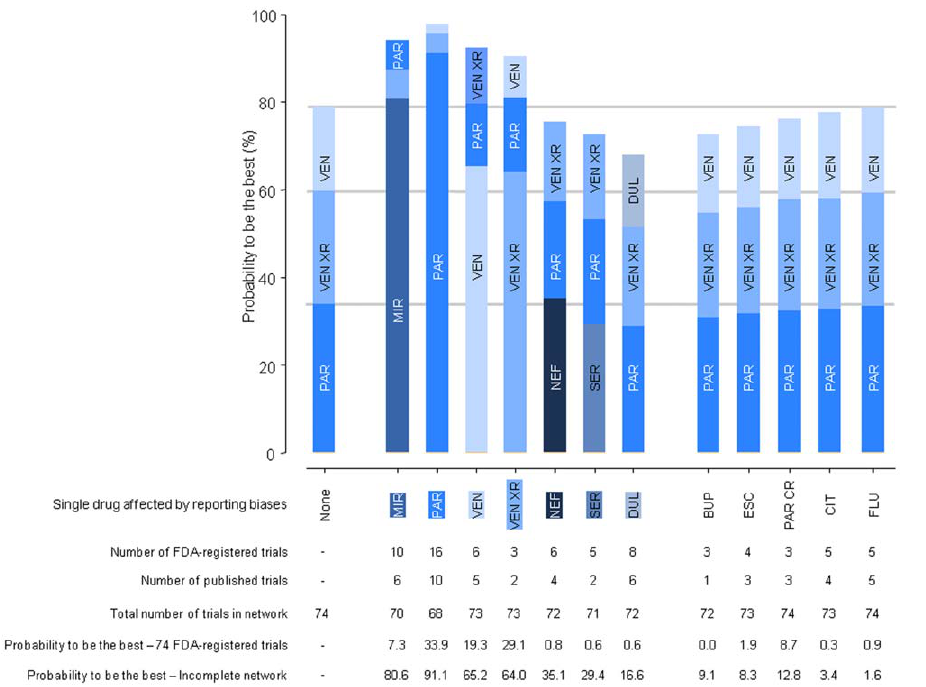
Figure 4. Probabilities of being the best among competing antidepressant agents when reporting bias affects one specific agent. The first stacked bar at the left corresponds to the network meta-analysis free of reporting biases (ie, with the data from the 74 FDA-registered trials). The other stacked bars correspond to the 12 network meta-analyses in which reporting bias hypothetically affects one specific agent in turn. For instance, for mirtazapine, we used the 6 published trials (out of 10 FDA-registered trials), with published effect sizes, and data from the 64 FDA- registered trials for the other 11 agents, which resulted in an incomplete FDA network of 70 trials; the probability of mirtazapine being the best was 80.6% with data from the incomplete FDA network and 7.3% with data from the 74 FDA-registered trials. For the sake of clarity, we presented in each analysis the 3 drugs with the 3 highest probabilities of being the best among competing antidepressant agents. Bup: Bupropion; Cit: Citalopram; Dul : Duloxetine ; Esc: Escitalopram; Flu: Fluoxetine; Mir: Mirtazapine ; Nef: Nefazodone ; Par: Paroxetine; Par CR: Paroxetine CR; Ser: Sertraline; Ven: Venlafaxine; VenXR: Venlafaxine XR.